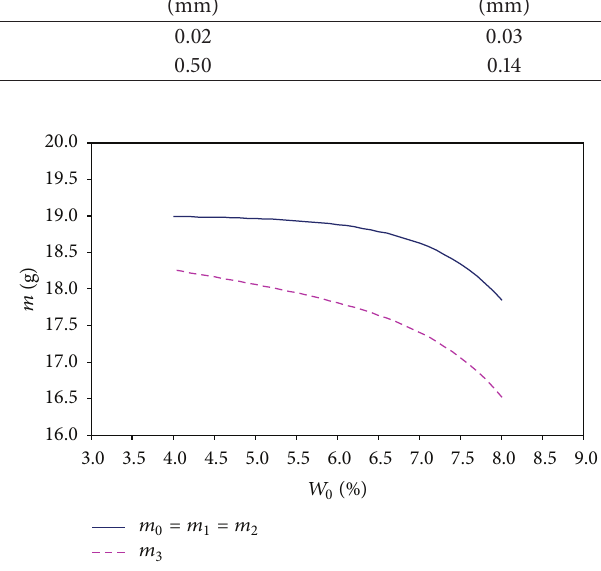
Figure 11: Influence of spray-dried powder moisture ( 𝑊 0 ) on the fill mass ( 𝑚 0 ) and tile masses ( 𝑚 1 , 𝑚 2 , and 𝑚 3 ).